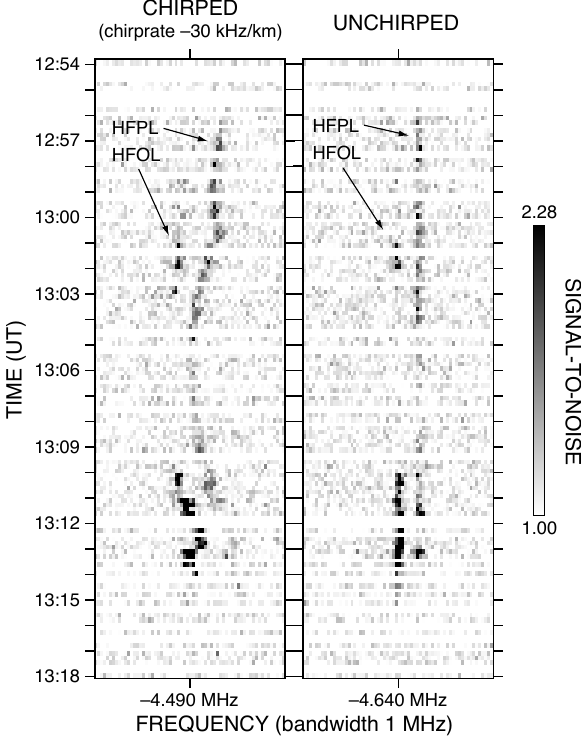
Fig. 4. UHF incoherent scatter radar spectra of HF-enhanced plasma lines from 1 December 1997. The spectra are most intense in the vicinity of the field-aligned position of the antenna, which in this example occurred at 13:00 to 13:01 and 13:12 to 13:13 UT. In both panels the right-hand line is the normal HF-enhanced plasma line, while the left-hand line is the free mode or outshifted line, shifted away from the radar transmission frequency, towards more negative frequencies for these downshifted waves. This effect was measured at HF pump frequencies of 4.9128MHz, 4.544MHz (the data shown here), and 4.040MHz. Reproduced from Isham et al. (1999c), Fig.